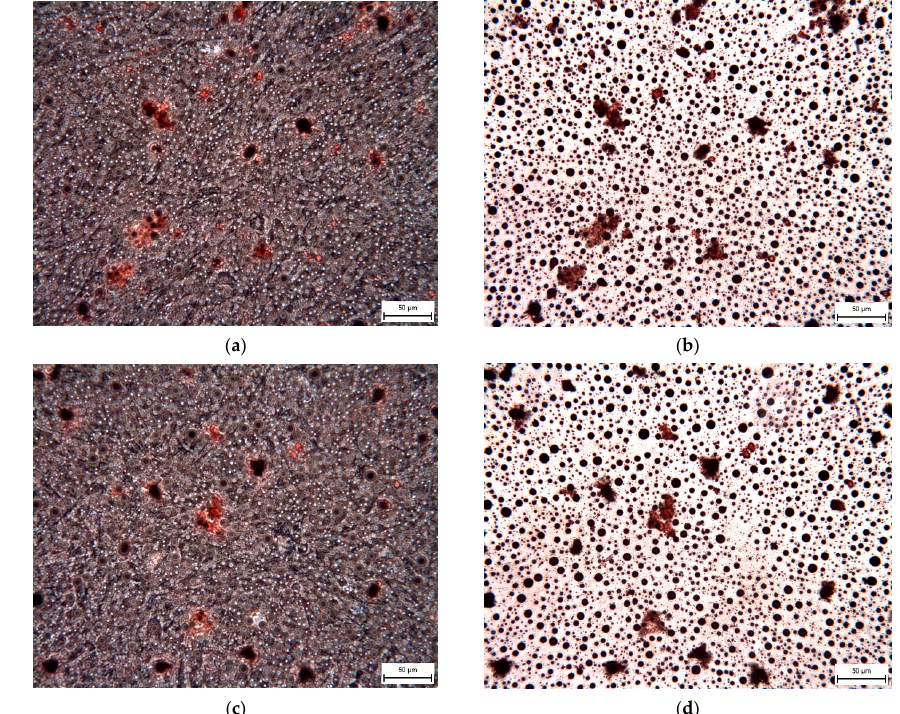
Figure 13. Detection of osteogenic differentiation in the extracellular matrix of hNDP-SCs cultivated in the hPL-culture medium. Scale bar 50 µ m: ( a – c ) After 3-week cultivation in osteogenic differentiation medium; ( d – f ) undifferentiated hNDP-SCs; ( a , d ) immunocytochemical detection of osteocalcin (brown or rusty areas); ( b , e ) histological detection of calcium phosphate deposits after von Kossa stain (dark brown or black spots); ( c , f ) histological detection of calcium deposits after Alizarin Red stain (red areas).